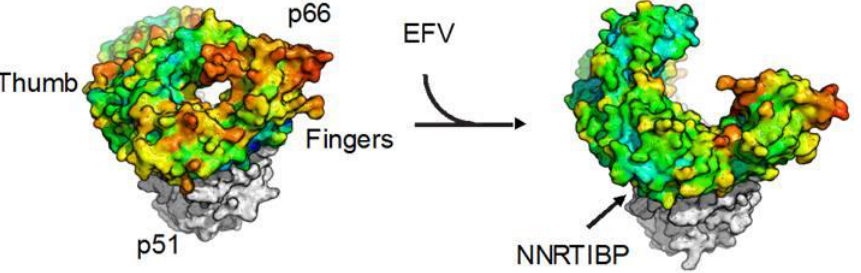
Figure 4. Molecular arthritis. The structures of apo wild-type (WT) RT (left; PDB ID: 1DLO) and WT RT bound to efavirenz (right; PDB ID: 1FK9). Structures are represented by solvent-accessible surface area. The p51 subunit is colored in grey, and the p66 subunit is colored according to crystallographic B-factors, with blue being the least mobile and red the most mobile residues. EFV, efavirenz; NNRTIBP, NNRTI binding